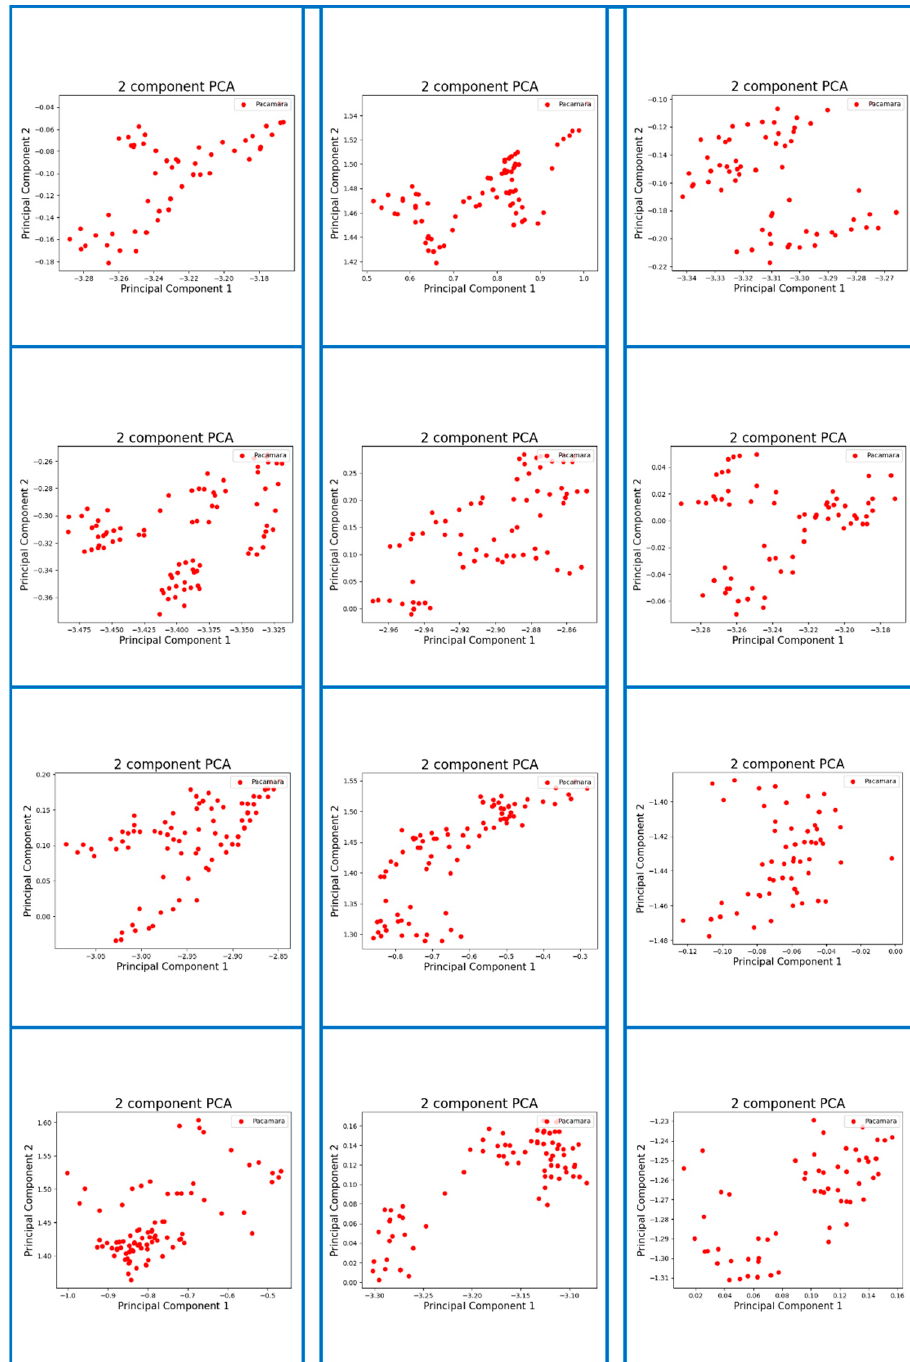
Figure A2. Sample digital fingerprints of coffee aromas originating from Pacamara, Nicaragua.